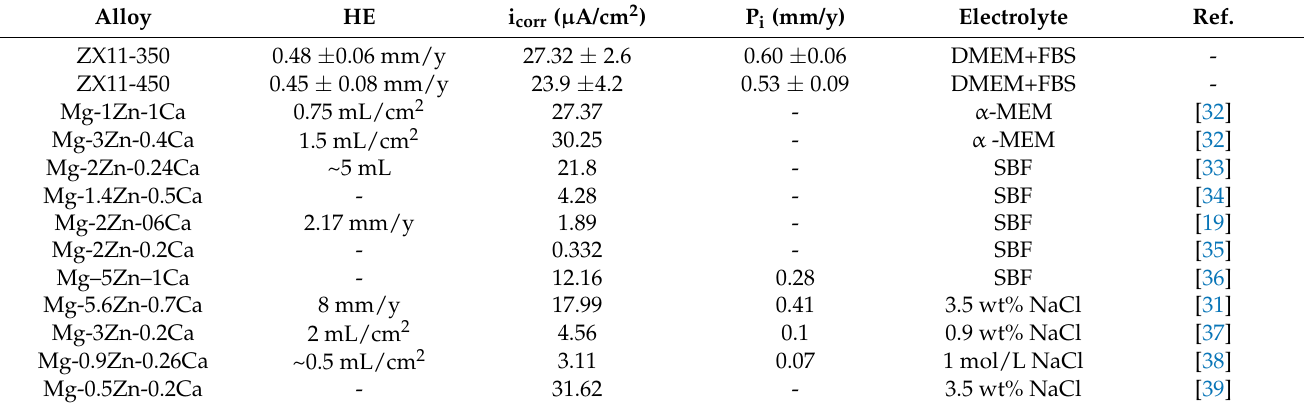
Table 2. Corrosion evaluation by potentiodynamic polarization and hydrogen evolution (HE).